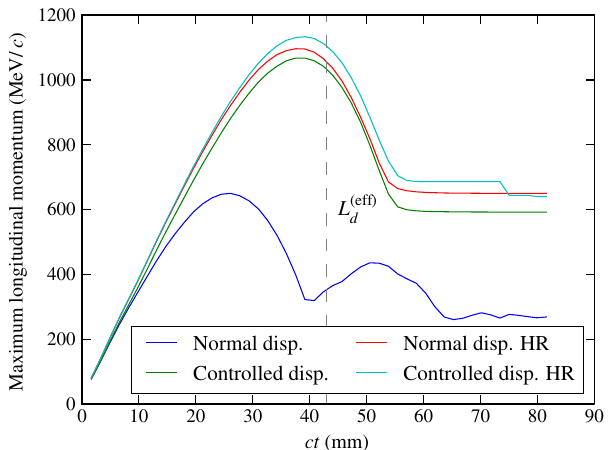
FIG. 2. The maximum test particle momentum, as a function of normalized propagation time, which is approximately equal to propagation distance. The dashed line indicates the effective ¼ 43 : 0 mm . In the legend, ‘‘HR’’ linear dephasing length, L d refers to the high resolution simulations, with (cid:1) x ¼ (cid:1) 0 = 32 ; those not labeled HR have (cid:1) x ¼ (cid:1) 0 = 16